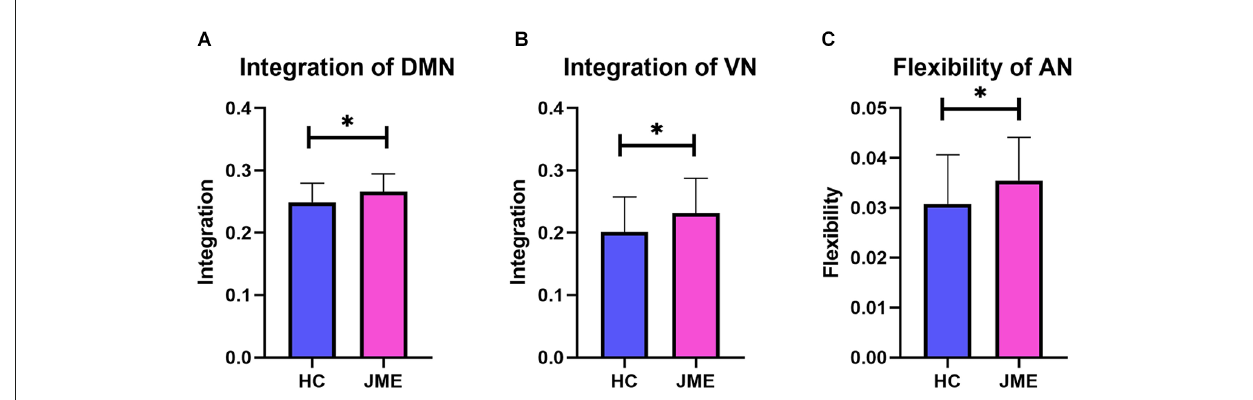
FIGURE3 Differences in metrics results between the healthy control groups and the JME groups at functional networks level. (A) Integration of DMN. (B) Integration of VN. (C) Flexibility of AN. Asterisks represent group differences; ∗ denotes P < 0.05, FDR-corrected.